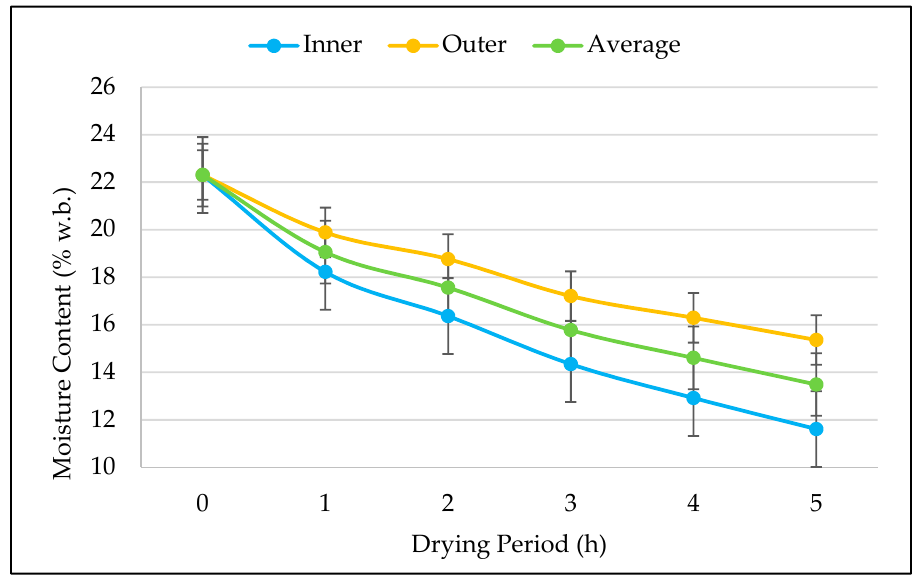
Figure 6. Temperature variations at L1, L2, and L3 in the drying chamber.